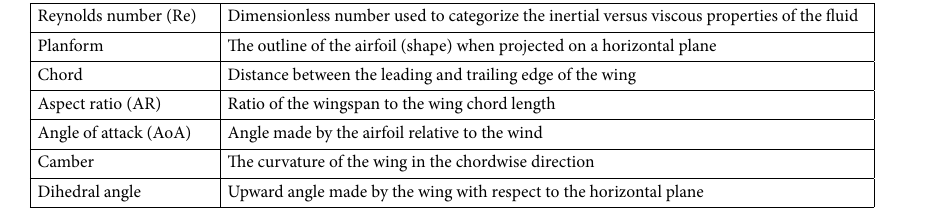
Table 1. Brief definitions of